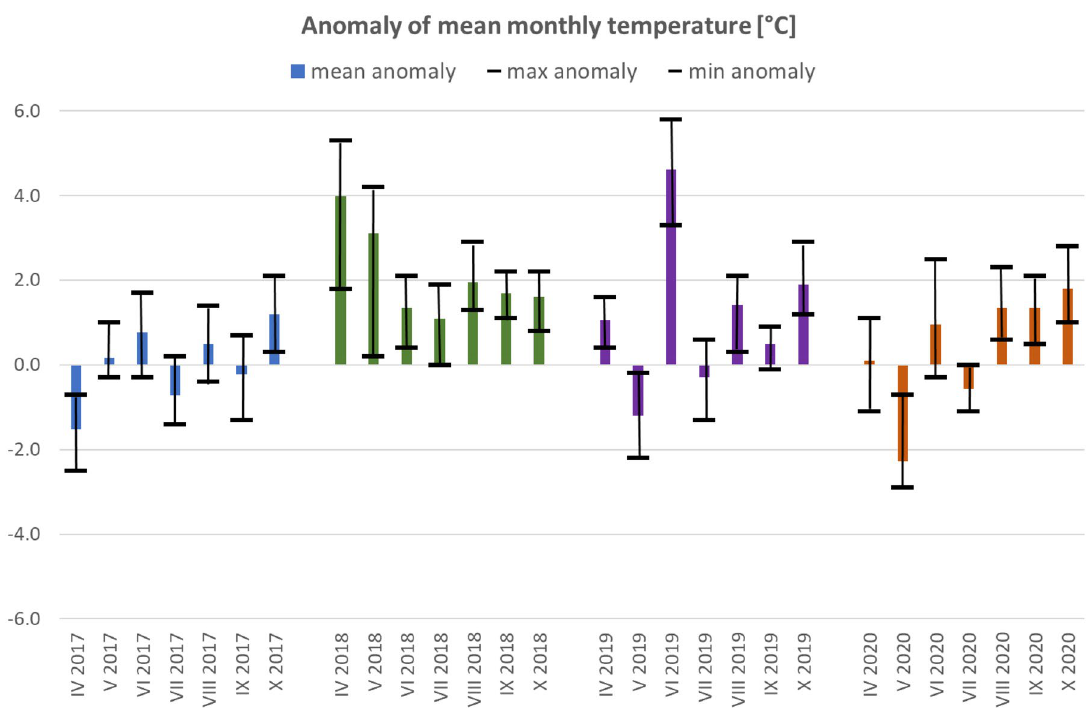
Figure 8. Ranges of anomaly of mean monthly temperature during the period 2017–2020 in reference to the climatological norm